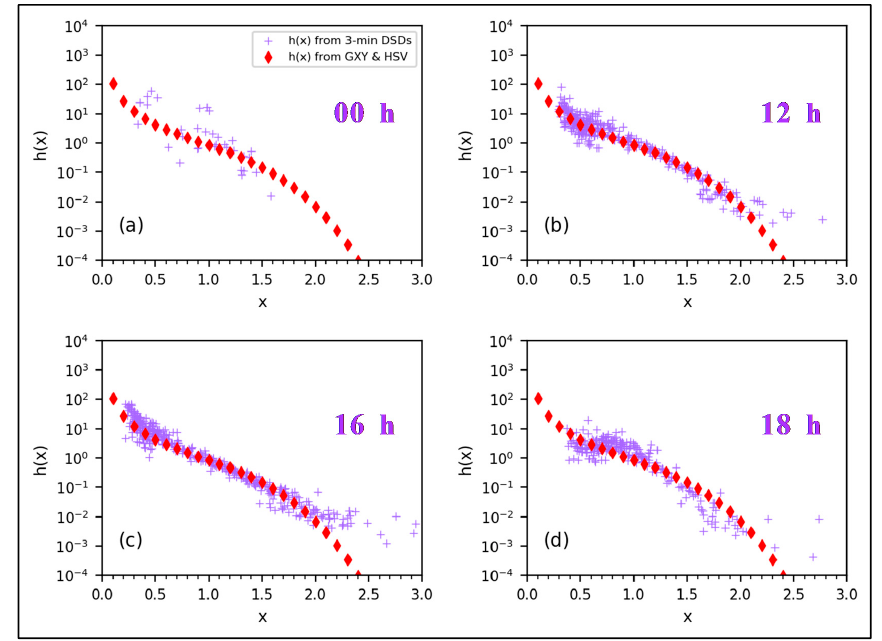
Figure 2. h(x) versus x derived from 3 min DSDs for ( a ) 00:00, ( b ) 12:00, ( c ) 16:00, and ( d ) 18:00 UTC, shown as purple crosses. Red diamonds represent most probable h(x) versus x from composite DSDs from the Greeley (GXY) and Huntsville (HSV) datasets with more than 4000 3 min DSDs from a variety of rain types [31].